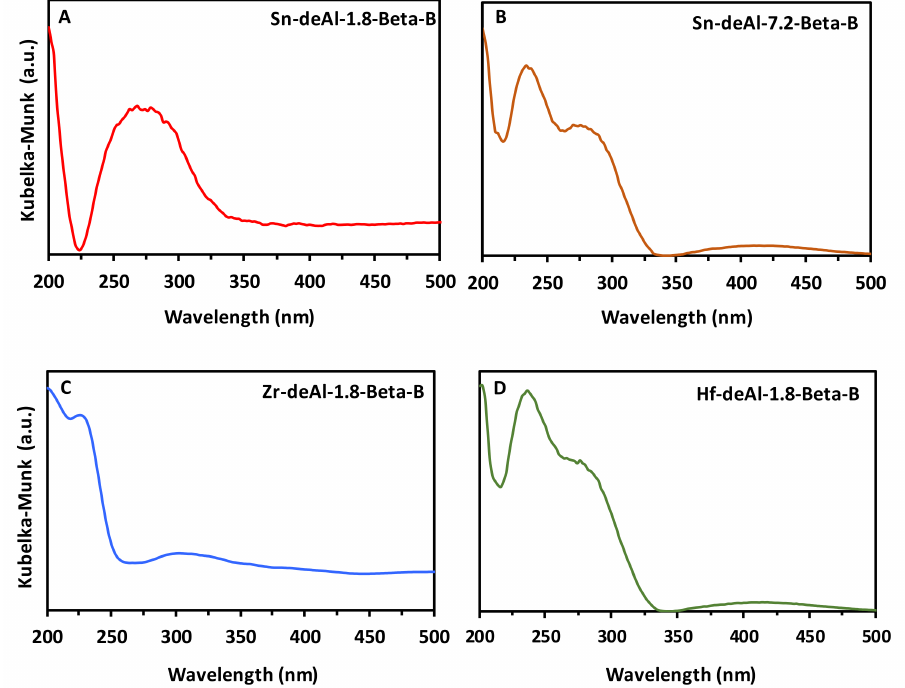
Figure 3. DR-UV-Vis spectra of metal-containing zeolite Beta beads after Kubelka–Munk correction: ( A ) Sn-deAl-1.8-Beta-B; ( B ) Sn-deAl-7.2-Beta-B; ( C ) Zr-deAl-1.8-Beta-B; ( D )